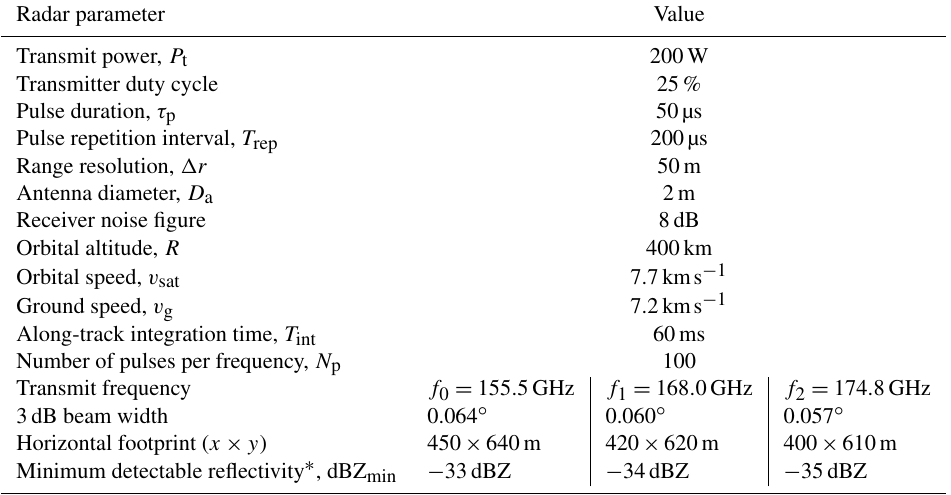
Table 2. High-level airborne VIPR system